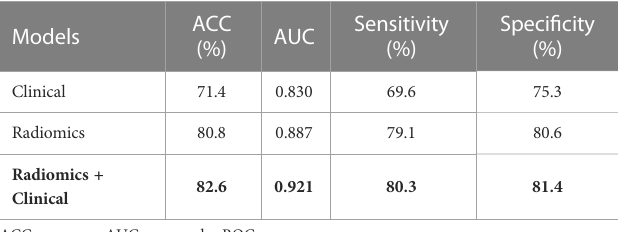
TABLE 5 Comparison of prediction performance of different models in the testing dataset.